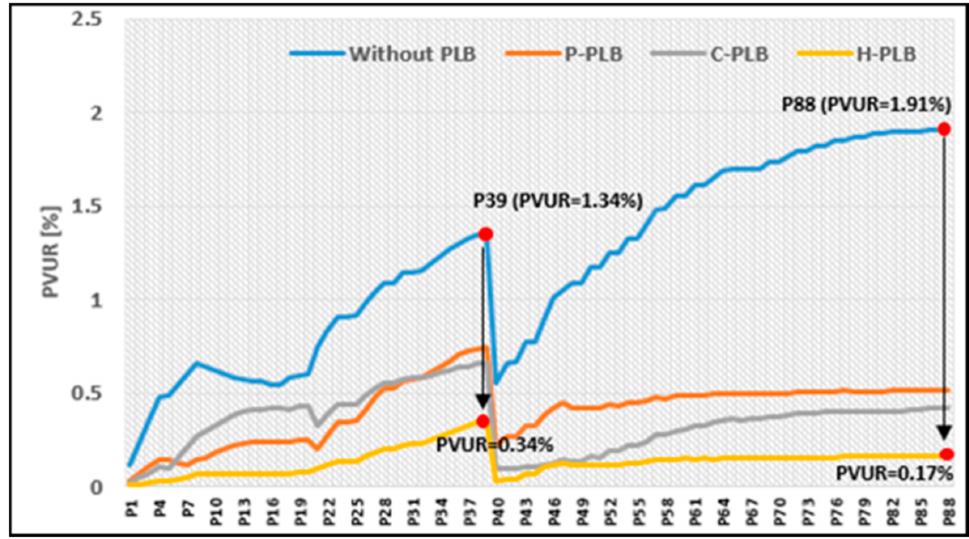
Figure 22. The variation of the PVUR at the level of poles before and after applying the PLB process. The highest decrease in the PVUR has been obtained in the case of the H-PLB algorithm. The PUVR has been improved from 1.34% to 0.34%, and from 1.91% to 0.17%, respectively, at the level of the end poles, P39 and